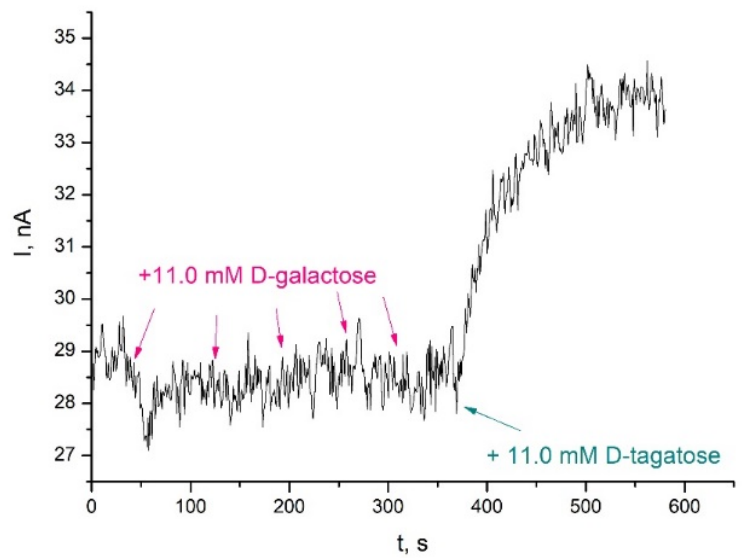
Figure 6. TRGO/FDH responses to D-galactose and D-tagatose. Measurement was performed in a stirred McIlvaine buffer solution, pH 4.5, 20 °C, under potentiostatic conditions (0.4 V vs. Ag/AgCl).